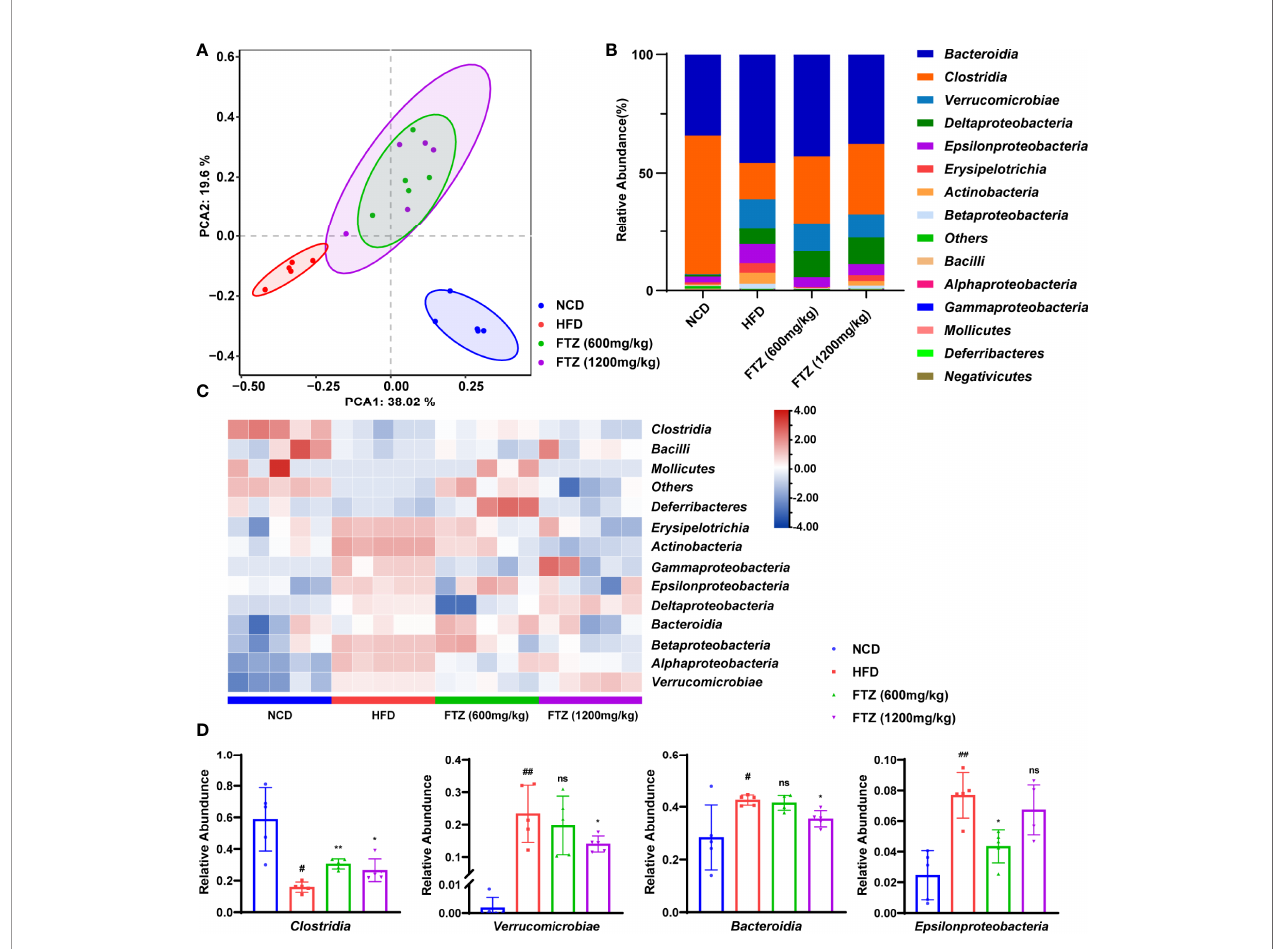
FIGURE 6 | Effects of FTZ on the intestinal fl ora compartment of mice. (A) PCA score plot (n=5). (B) Average class distribution of gut microbiomes. (C) The heat map (clustered at class level) showing that the fl ora was signi fi cantly altered by HFD and FTZ treatment compared to NCD (n=5). (D) The comparison of the taxonomic abundance of the indicated groups (n=5). Data are represented as means ± SEM. # indicates a signi fi cant difference between the NCD group and the HFD group (t-test); * indicates a signi fi cant difference between the FTZ (600 mg/kg)/FTZ (1,200 mg/kg) group and the HFD group (one-way ANOVA). # P < 0.05, ## P < 0.01 versus NCD mice; * P < 0.05, ** P < 0.01 versus mice fed by HFD. ns indicates no signi fi